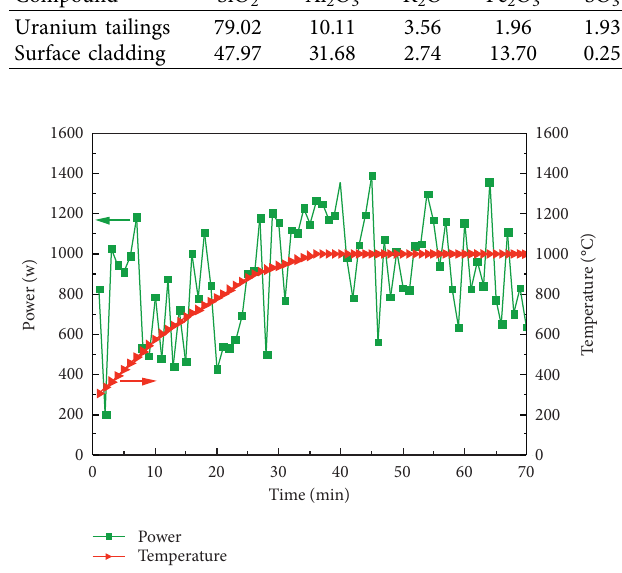
Figure 1: The real-time power and temperature output as a function of time.